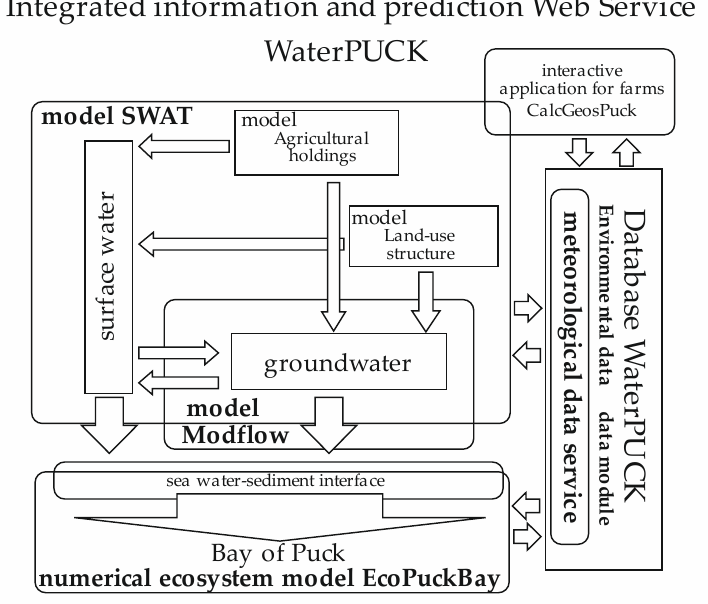
Figure 3. Scheme of the WaterPUCK project [25].